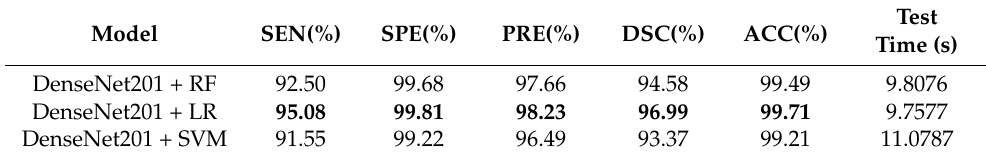
Table 8. The performance evaluation for DenseNet201 combined with different classifiers.